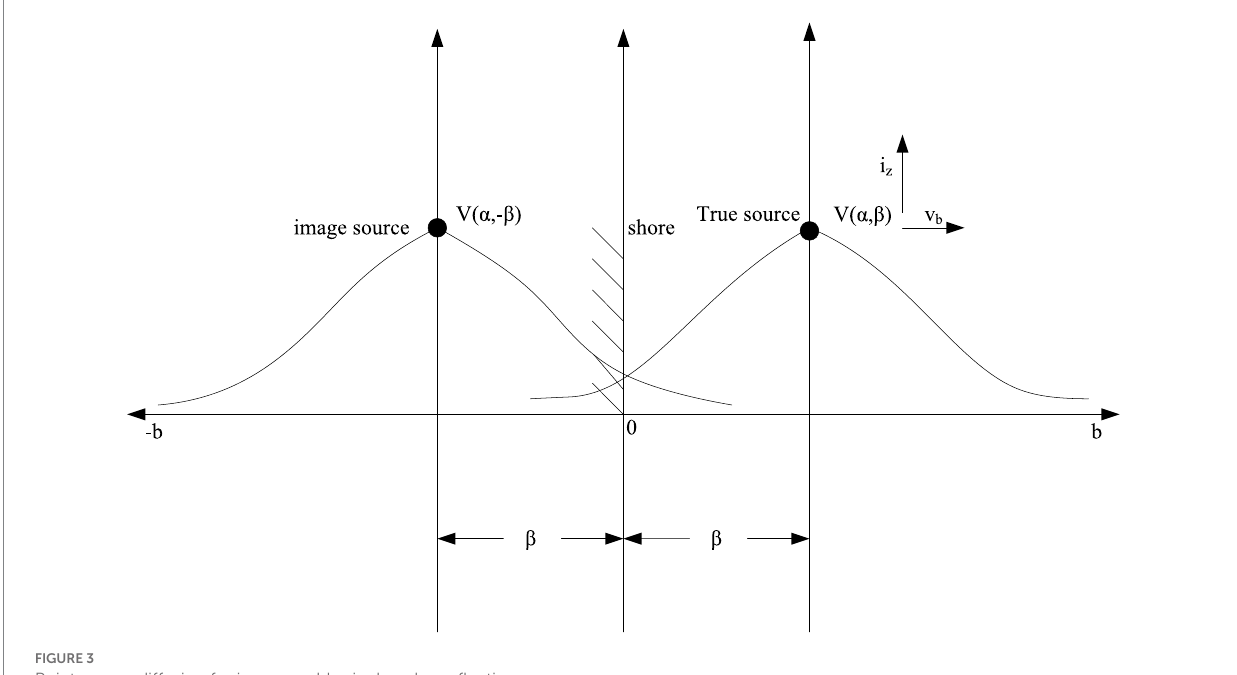
FIGURE 3 Point source diffusion for impermeable single-edge